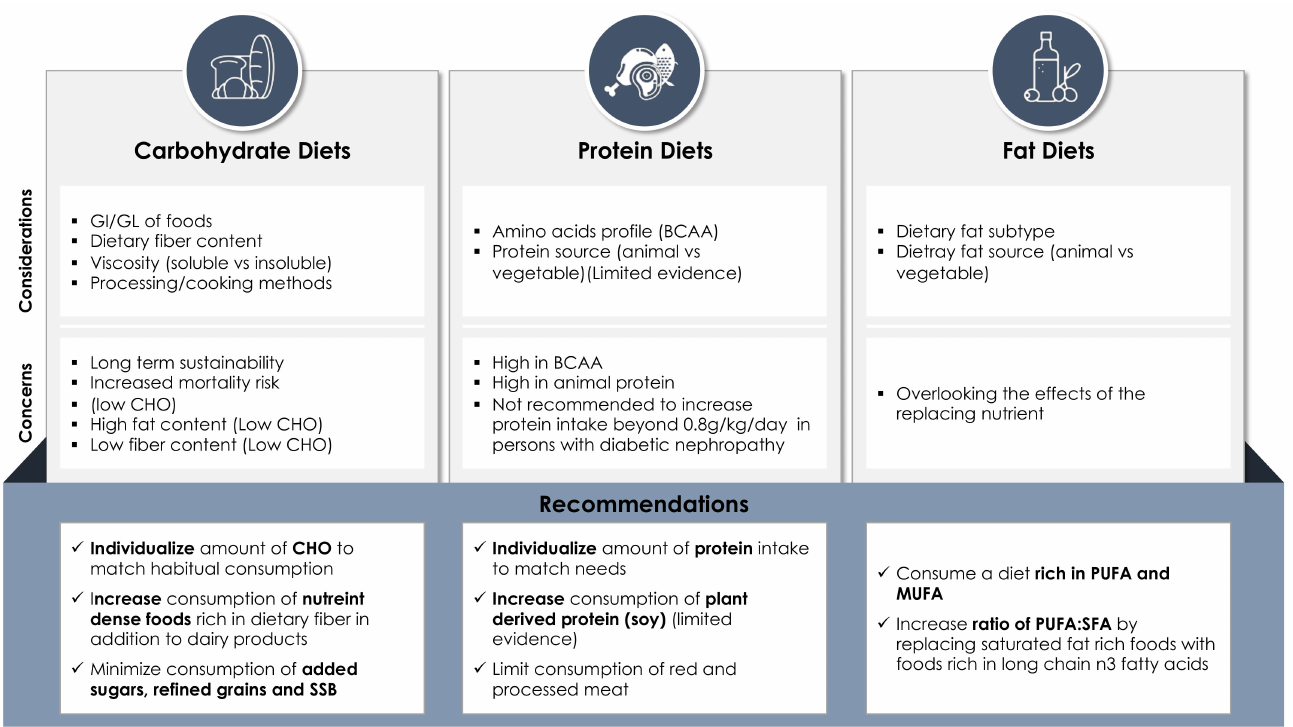
Figure 3. Summary of considerations, concerns and recommendations for macronutrient-focused diets in diabetes manage- ment.GI: glycemic index; GL: glycemic load; SSB: sugar sweetened beverages; PUFA: polyunsaturated fatty acids; MUFA: monounsaturated fatty acids; SFA: saturated fatty